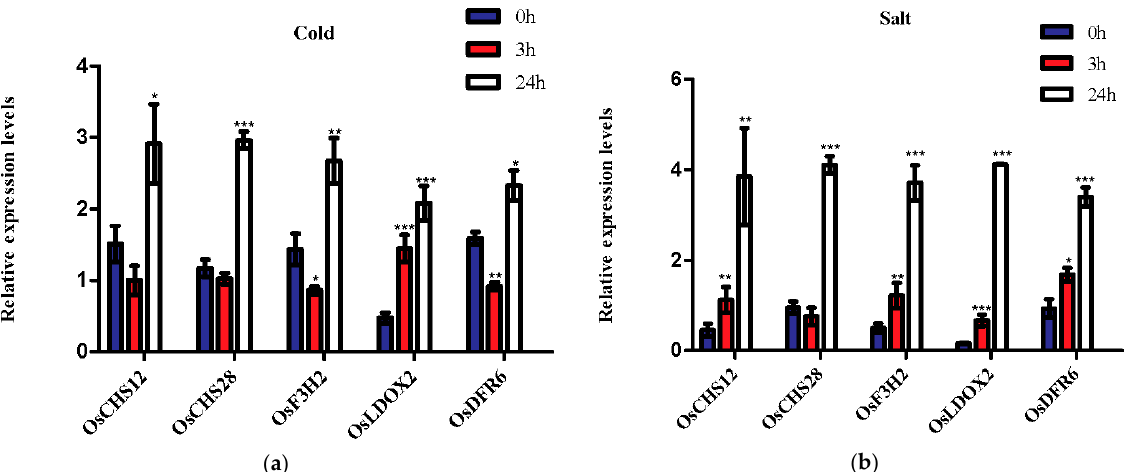
Figure 6. qRT-PCR analysis of the five cold- ( a ) and salt- ( b ) responsive genes involved in the biosynthesis of rice flavonoid scaffolds after 200 mM NaCl and cold (4 °C) treatment for 0 h, 3 h and 24 h. The relative expression values were calculated by 2 − ΔΔ CT method. The bars indicate the standard deviation of 3 biological replicates; * shows a significant difference relative to the 0 h group (* p < 0.05, ** p < 0.01, *** p < 0.001).